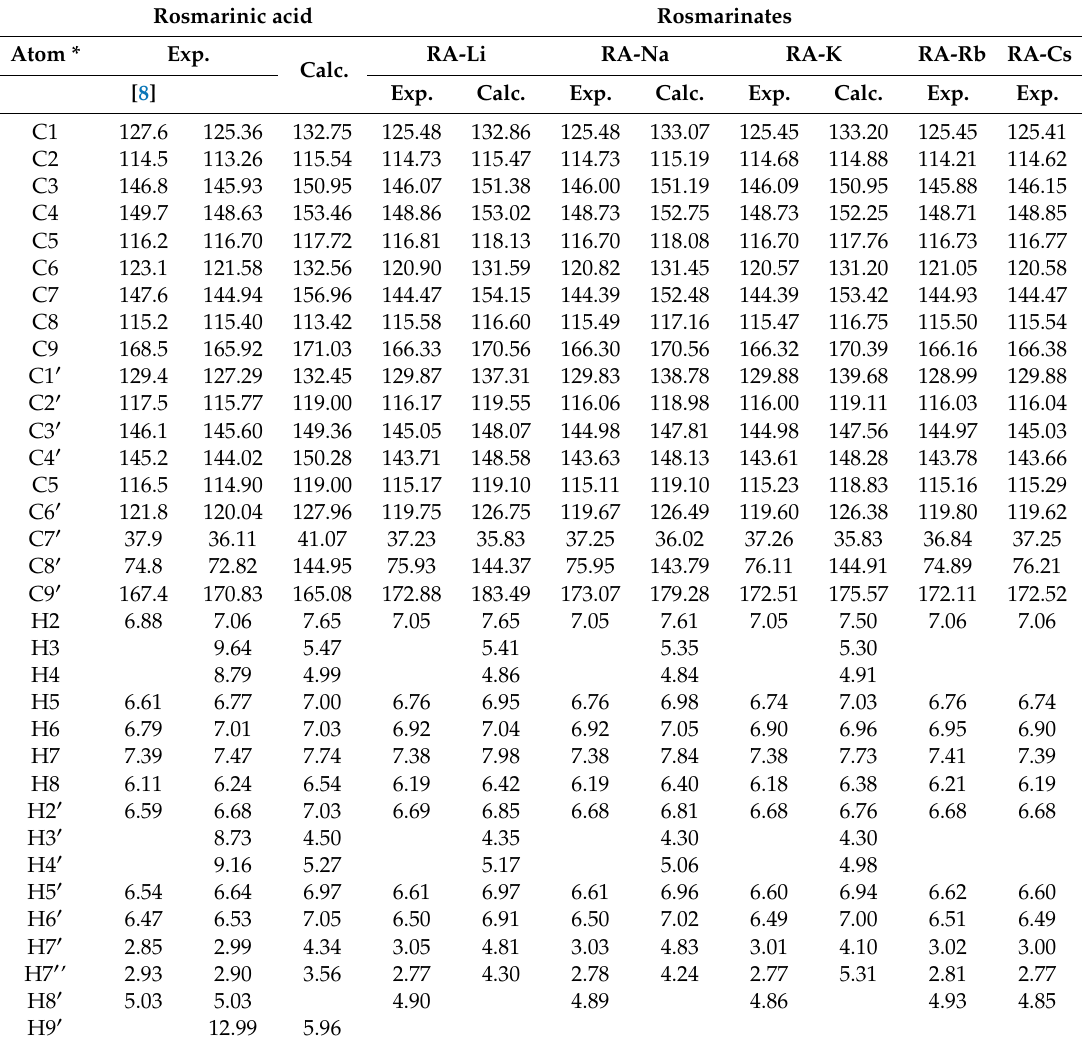
Table 6. The experimental and theoretical (6-311 + G(d.p)) chemical shifts ( δ / ppm) of protons and carbons in NMR spectra of rosmarinic acid and its alkali metal salts in DMSO